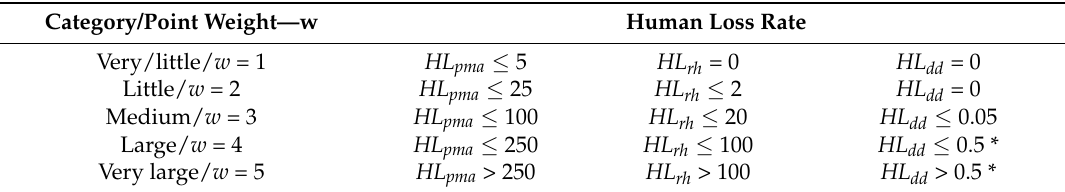
Table 3. Category of human losses.